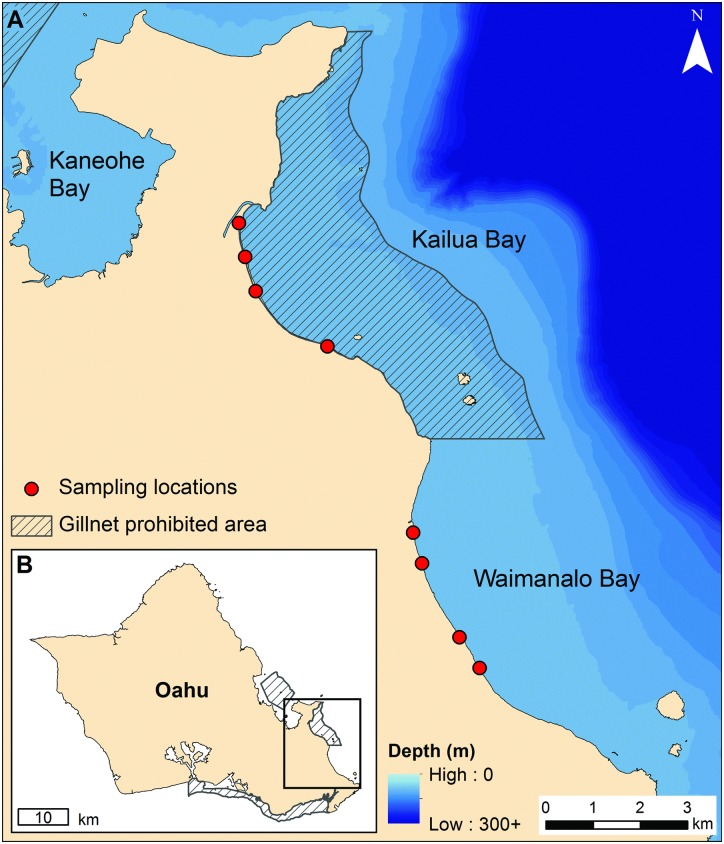
Map of study area showing gillnet prohibited area (hatched area) in Kailua Bay and open area in Waimanalo Bay (A) on the island of O‘ahu in Hawai‘i (B).Red circles show sampling locations, and depth contours are colored from light (shallow) to dark (deep).